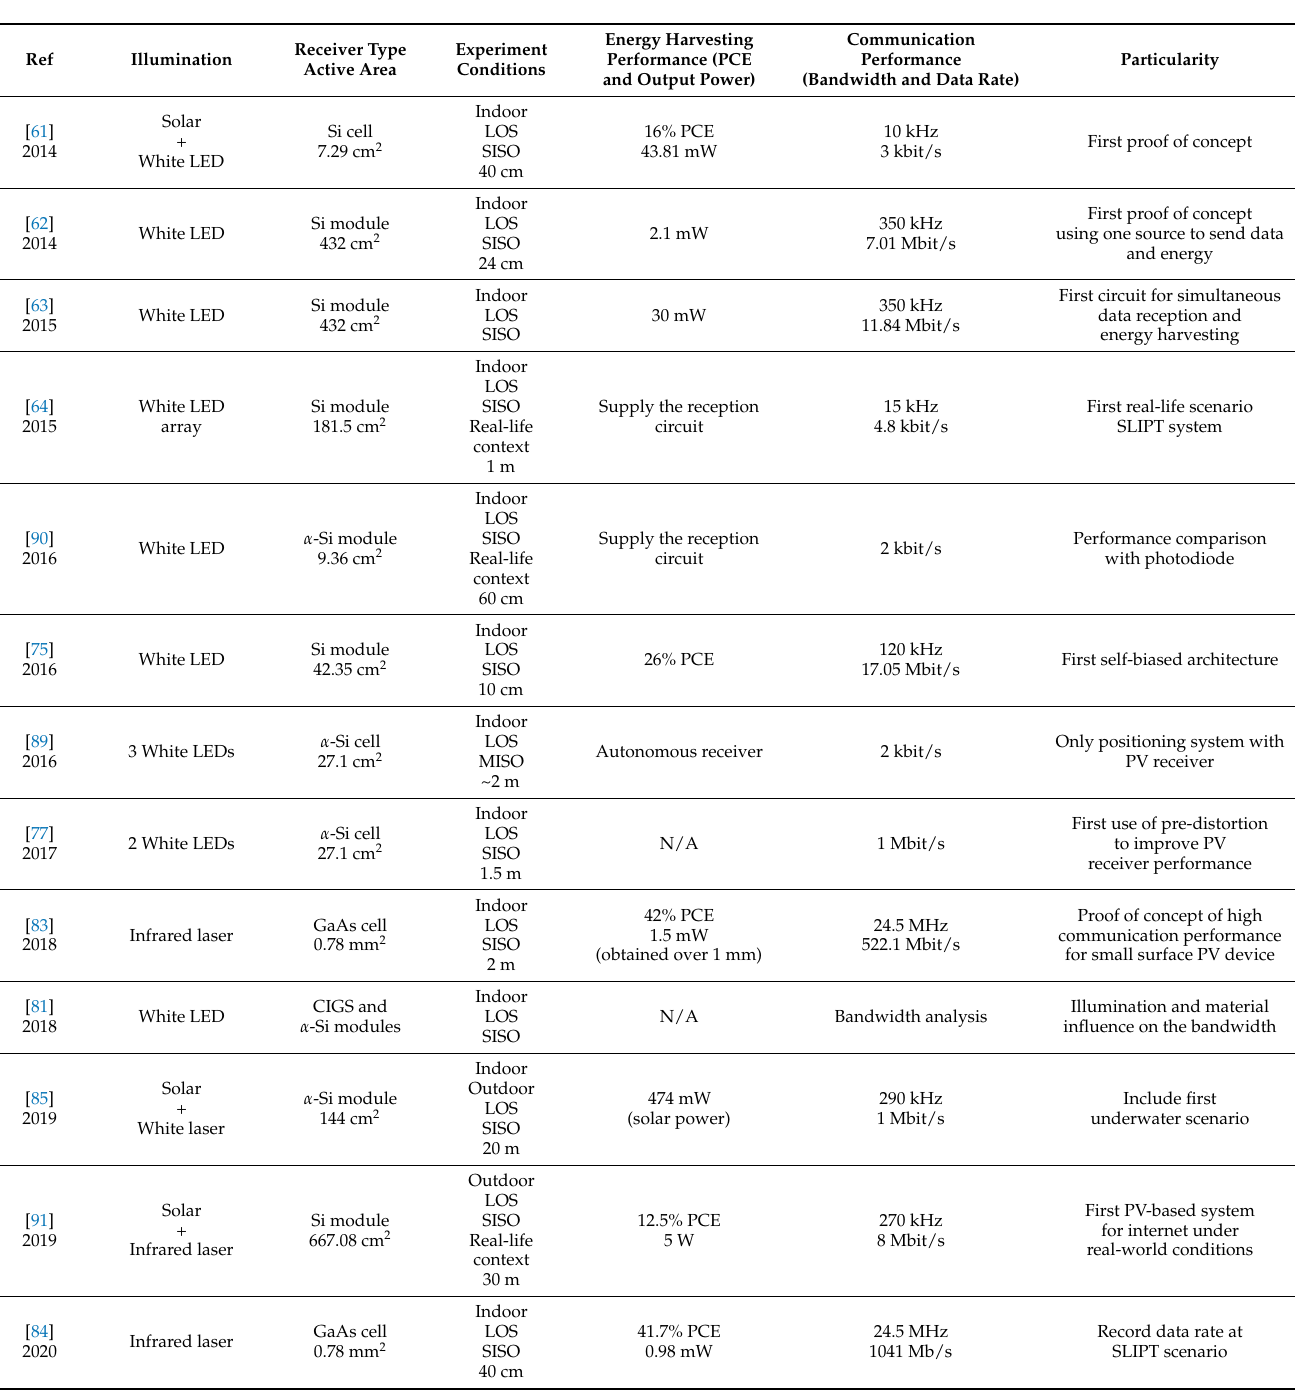
Table 2). We highlight the best performance obtained regarding energy harvesting and data reception, even though some of them were obtained under different conditions. Table 2. Summary of some of the most impactful contributions for SLIPT-based systems (with 1st and 2nd generation of PV devices) with their respective information about the illumination, receiver characteristics (PV technology, type of device, and active area size), experiment condition (type of link and distance between Tx and Rx), energy harvesting parameters (PCE and output power), communication performance (bandwidth and data rate), and most notable